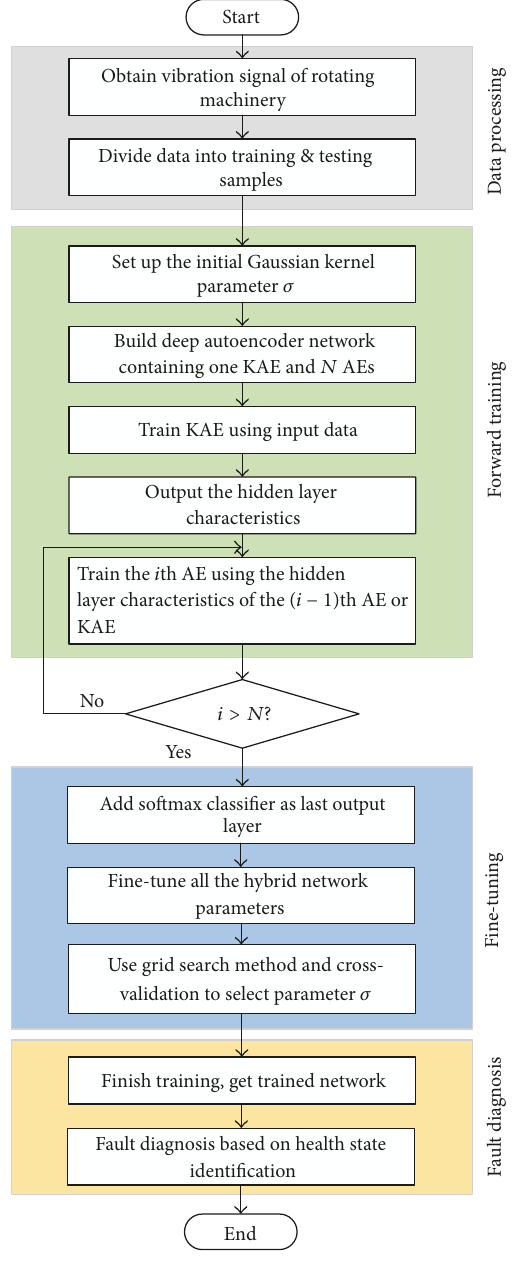
Figure 2: The flowchart of the proposed